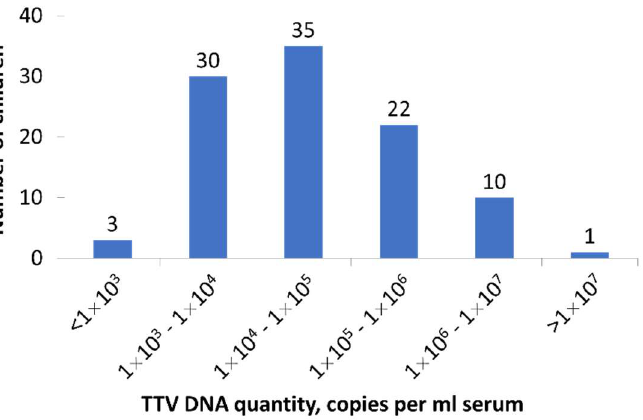
Figure 2. The histogram shows the distribution of TTV viral loads in the first TTV-DNA-positive sample of each child ( n = 101 children). The numbers above columns represent numbers of children.